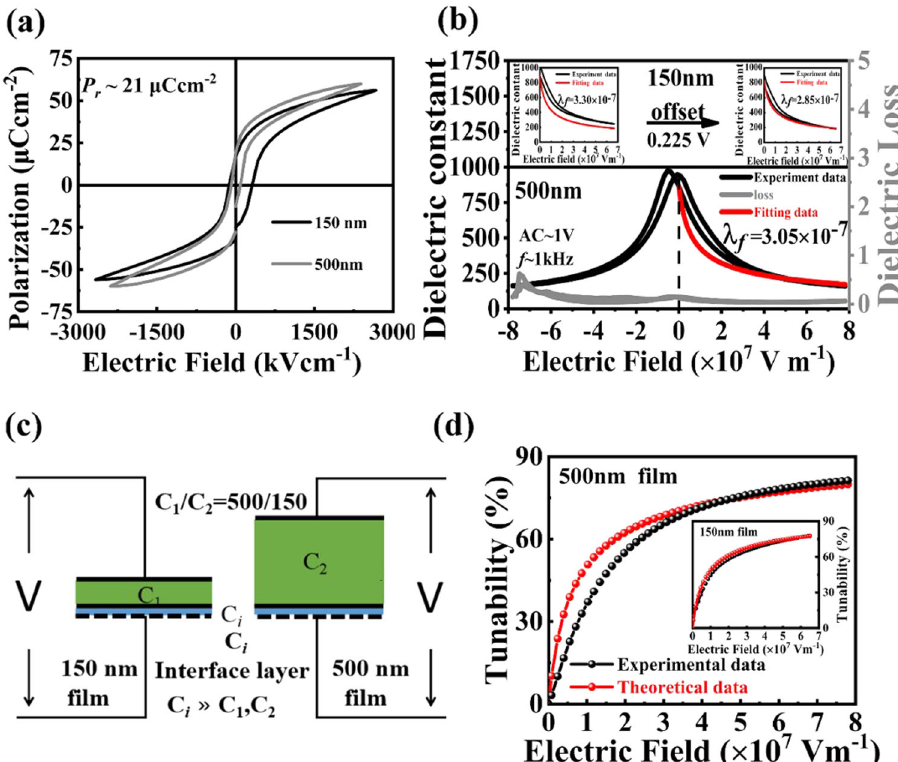
Fig. 6 Electrical performance of the KNN fi lms. a Polarization-electric fi eld ( P – E ) hysteresis loops (measured @1 kHz); b measured and computed dielectric permittivity χ -electric fi eld E ( χ - E ) curves of the 500nm-thick KNN fi lm ( λ f = 3.05 × 10 − 7 m V − 1 from Eq. 9), the inset shows the measured and computed χ - E curves ( E > 0) of the 150 nm-thick fi lm under 10V ( λ f = 2.85 × 10 − 7 m V − 1 from Eq. 9). The dielectric loss tangent-electric fi eld (tg δ - E ) curves are also shown for the 500 nm fi lm. c Schematic illustration of the effect of a capacitive interface layer on reducing the effective voltage across the KNN fi lm. The thinner the KNN fi lm, the larger the voltage drop on this interface layer. d Measured (@1 kHz) and computed dielectric tunabilities as functions of the bias fi eld for the 500 and 150 nm (inset) KNN fi